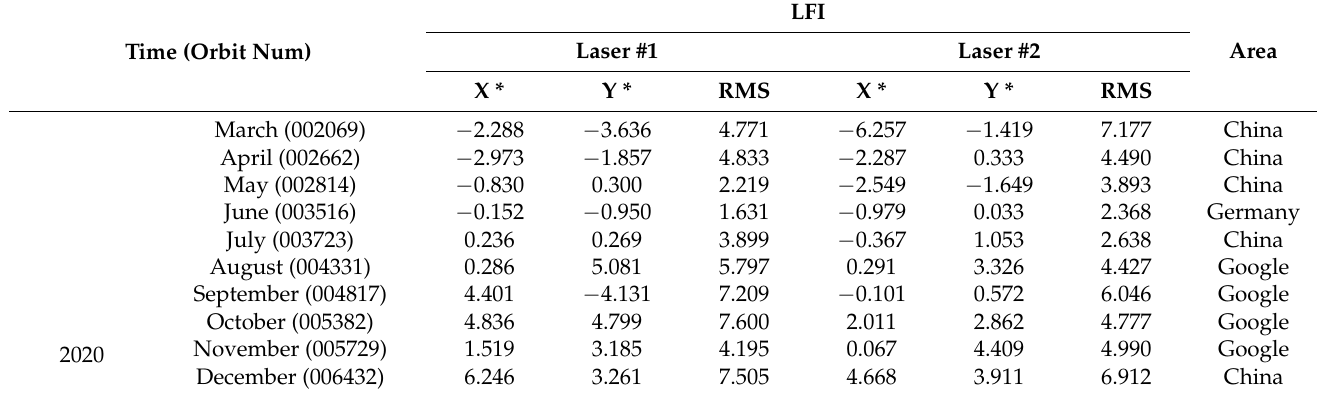
Table 5. Sampling inspection for plane accuracy evaluation of the laser footprint image (LFI; unit: